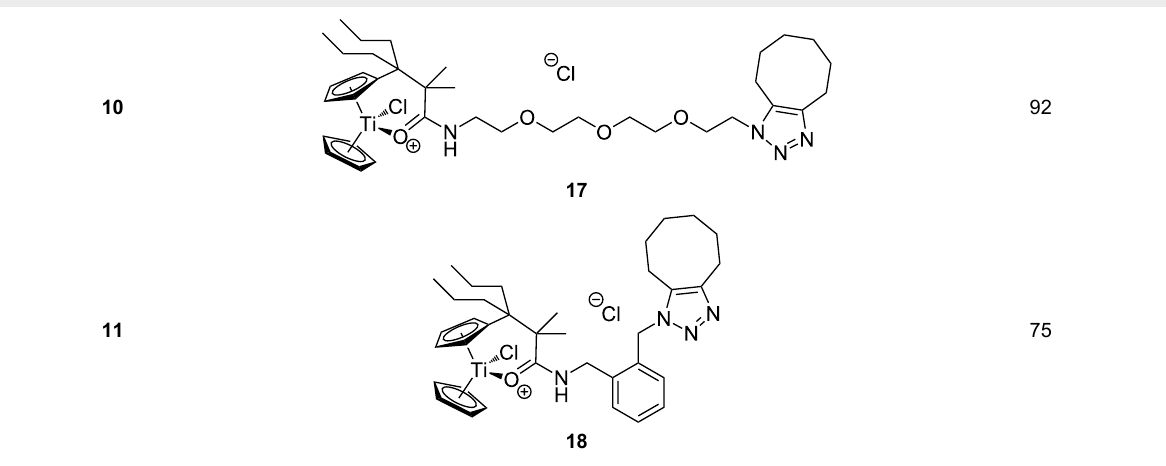
novel complexes. To guarantee comparability with a previous BJAB. Cell surface transmembrane receptor CD95,